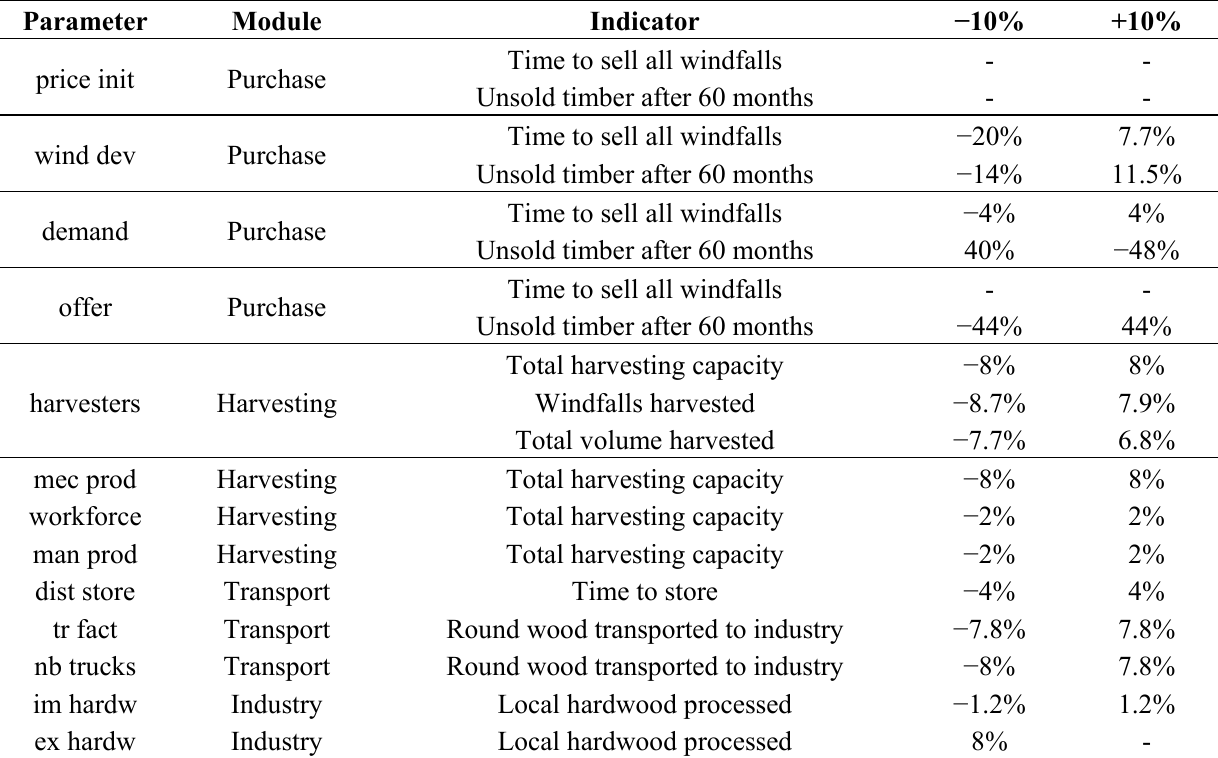
Table 1. Effect on model indicator of increasing or decreasing the selected parameters by 10%. Results express the difference from the reference state. The sign (-) reveals an under-estimation. Figures in bold indicate a significant difference (over 15%) between extreme